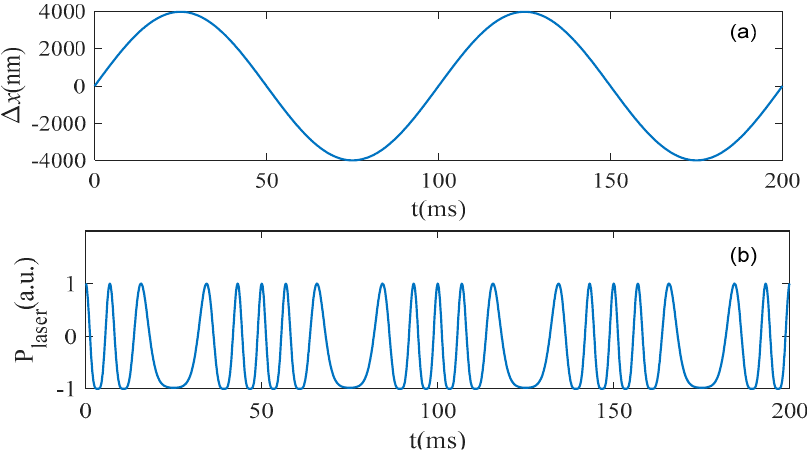
Figure 2. Simulation results of the LFI signal corresponding to in-plane displacement ∆ x (8000 nm p–p). ( a ) The simulated displacement of ∆ x . ( b ) The simulated LFI signal.